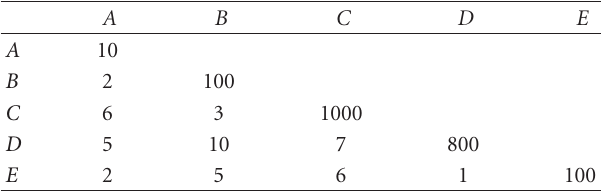
Table 2: Intersite and intrasite bandwidths expressed in